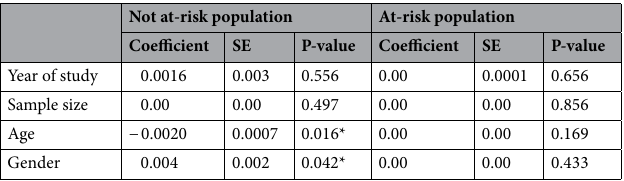
Table 5. Meta-regression analysis for exploring heterogeneity among studies.